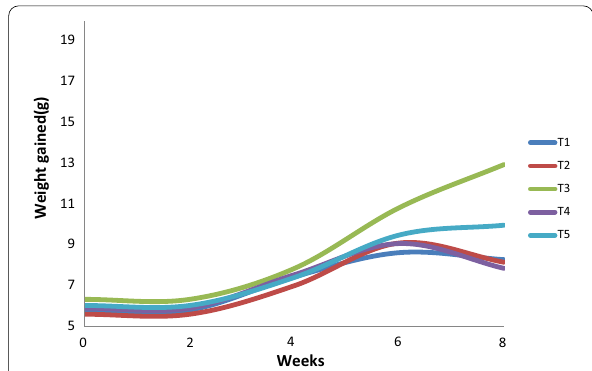
Fig. 1 Weight gain pattern of C. gariepinus fed with varying levels of ascorbic acid and iron nanoparticles